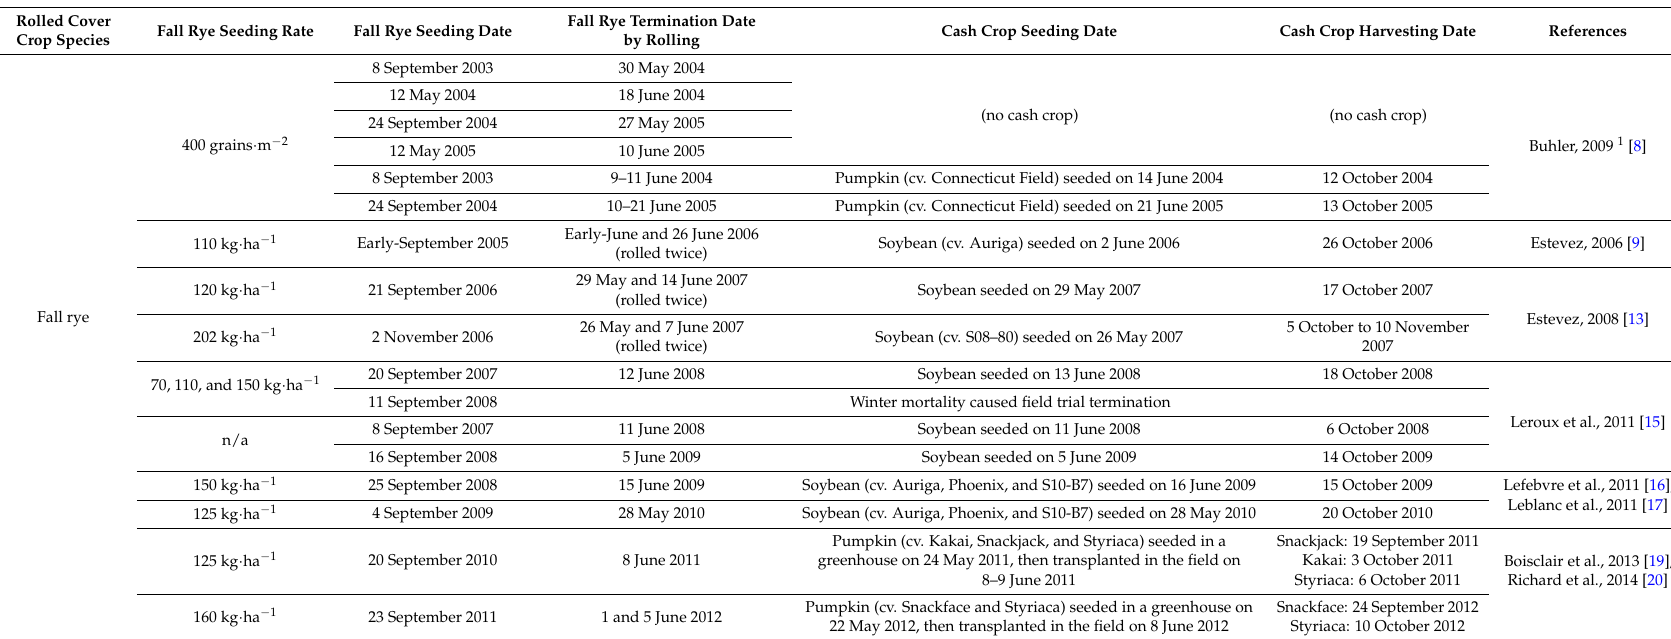
Table 2. Fall rye seeding rate, seeding date, termination date, and cash crop seeding and harvesting dates in organic no-till field trials in Eastern Canada using pure fall rye mulches between 2003 and